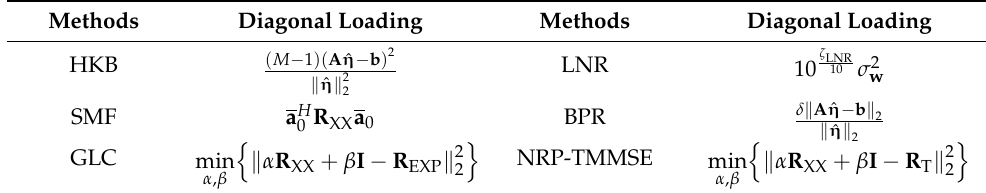
Table 1. Six Diagonal Loading Methods of the